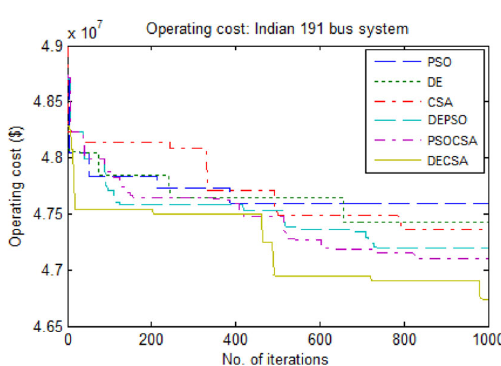
Fig. 9 Convergence behavior of OC from respective algorithms in System